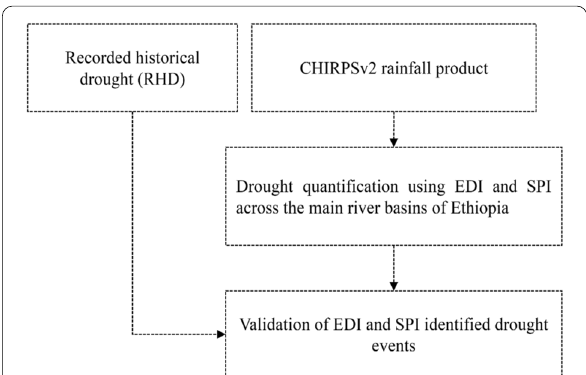
Fig. 2 The general framework adopted for meteorological drought assessment using CHIRPSv2 based EDI and SPI indices across the main river basins of